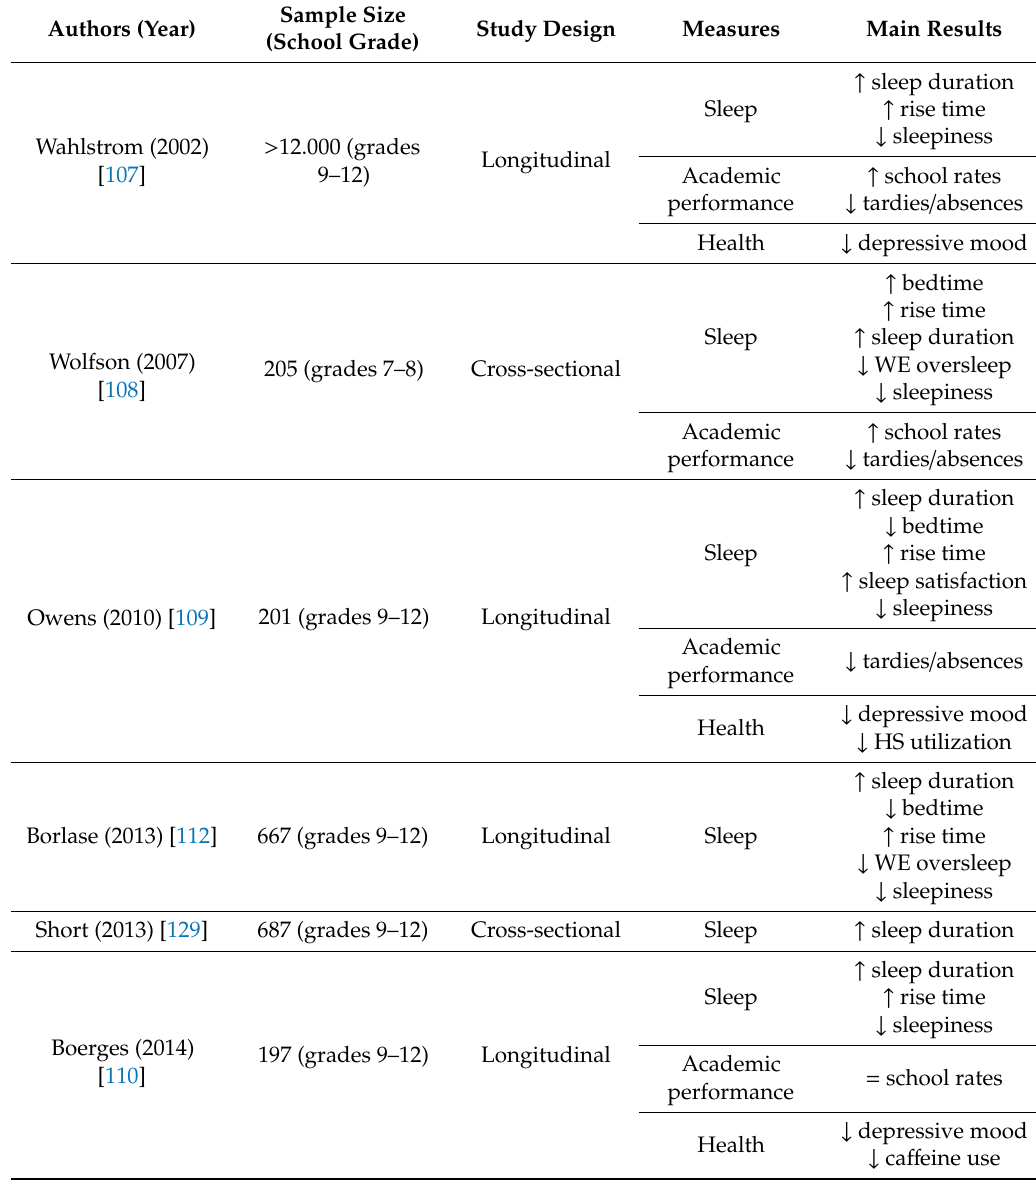
Table 1. Characteristics of the key studies on delayed school start